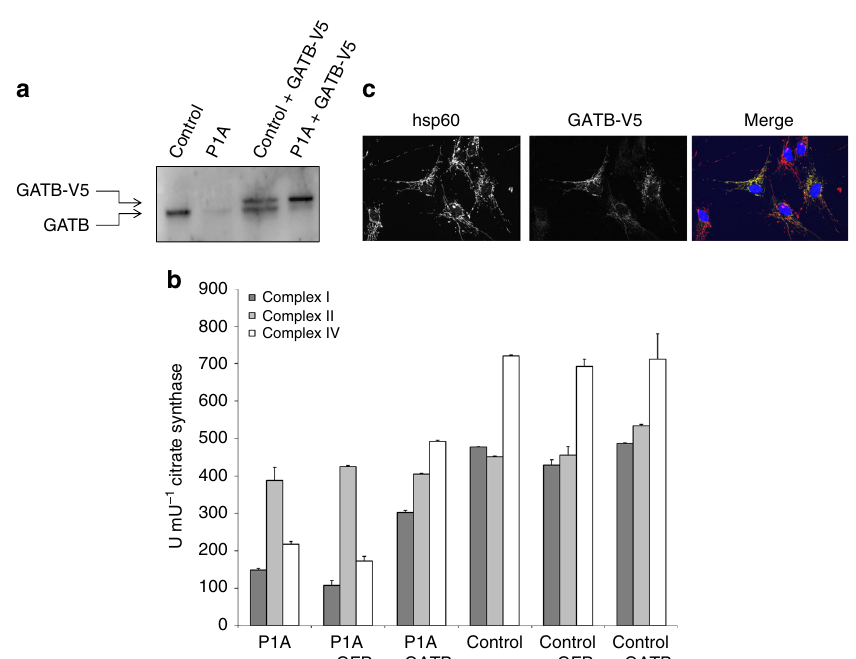
Fig. 6 Heterologous expression studies of GatB-V5. a Western blot of a SDS-PAGE gel show normal expression of endogenous GatB in the control cell line and near absence of this protein in the patient ’ s cells, whereas cells lentivirally transduced with GatB-V5 show a band running slightly higher than the endogenous GatB, corresponding to the slightly larger GatB-V5. The expression levels of GatB-V5 in the patient are similar to that of the endogenous GatB in the control cell line. b The activities of the respiratory chain enzymes complex I, II, and IV were measured in P1A and control fi broblasts, lentivirally transduced with GATB -V5 or GFP (as a negative control), and in non-transduced cells. The results show that the reduced activities of complexes I and IV, presented as mean and standard deviation, as seen in the non-transduced and GFP-transduced patient ’ s cells, are speci fi cally increased by the transduction of the patient ’ s cells with GATB -V5. There is no effect on complex II. In control cells, the expression of GFP or GATB -V5 has no effect on the activity of complex I, II, and IV. From this it is concluded that the enzyme de fi ciencies in P1A fi broblasts are caused by the pathogenic variants in GATB . c Subcellular localization study of GatB-V5 in U2OS cells, transiently transfected with a GATB -V5 expression construct, and stained using an antibody against V5 (targeting GatB-V5), and hsp60 as a mitochondrial localization marker show variable expression levels of GatB-V5 in different cells, which co-localizes with hsp60 in the merged image on the right-hand side. This shows that the GatB-V5 protein has an exclusively mitochondrial